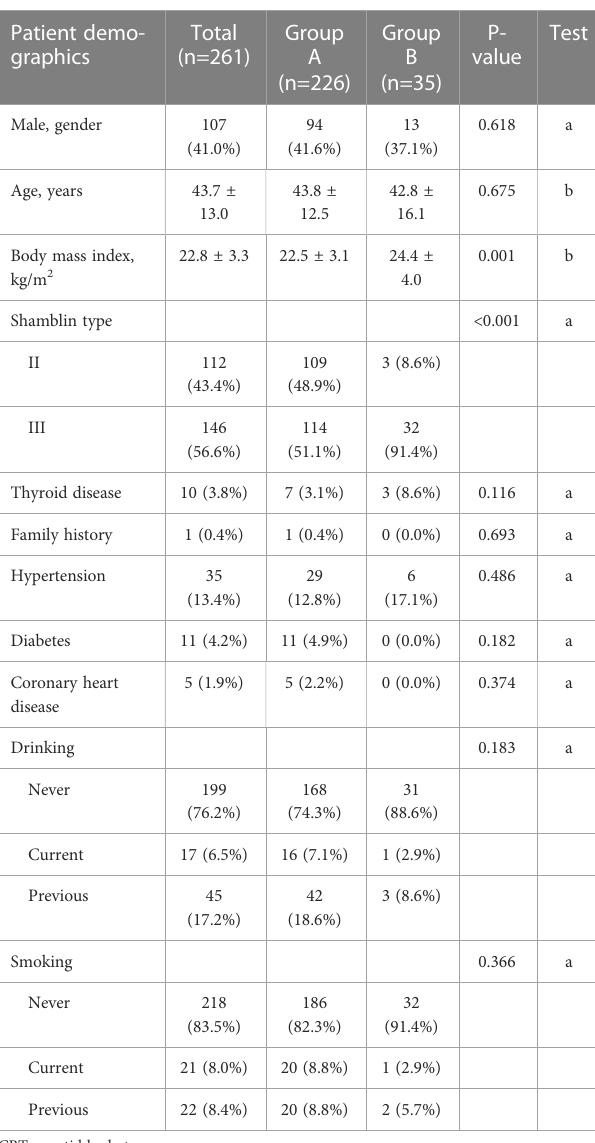
TABLE 1 Baseline demographics and characteristics for patients with CBT surgical resection alone (group A) or with preoperative embolization (group